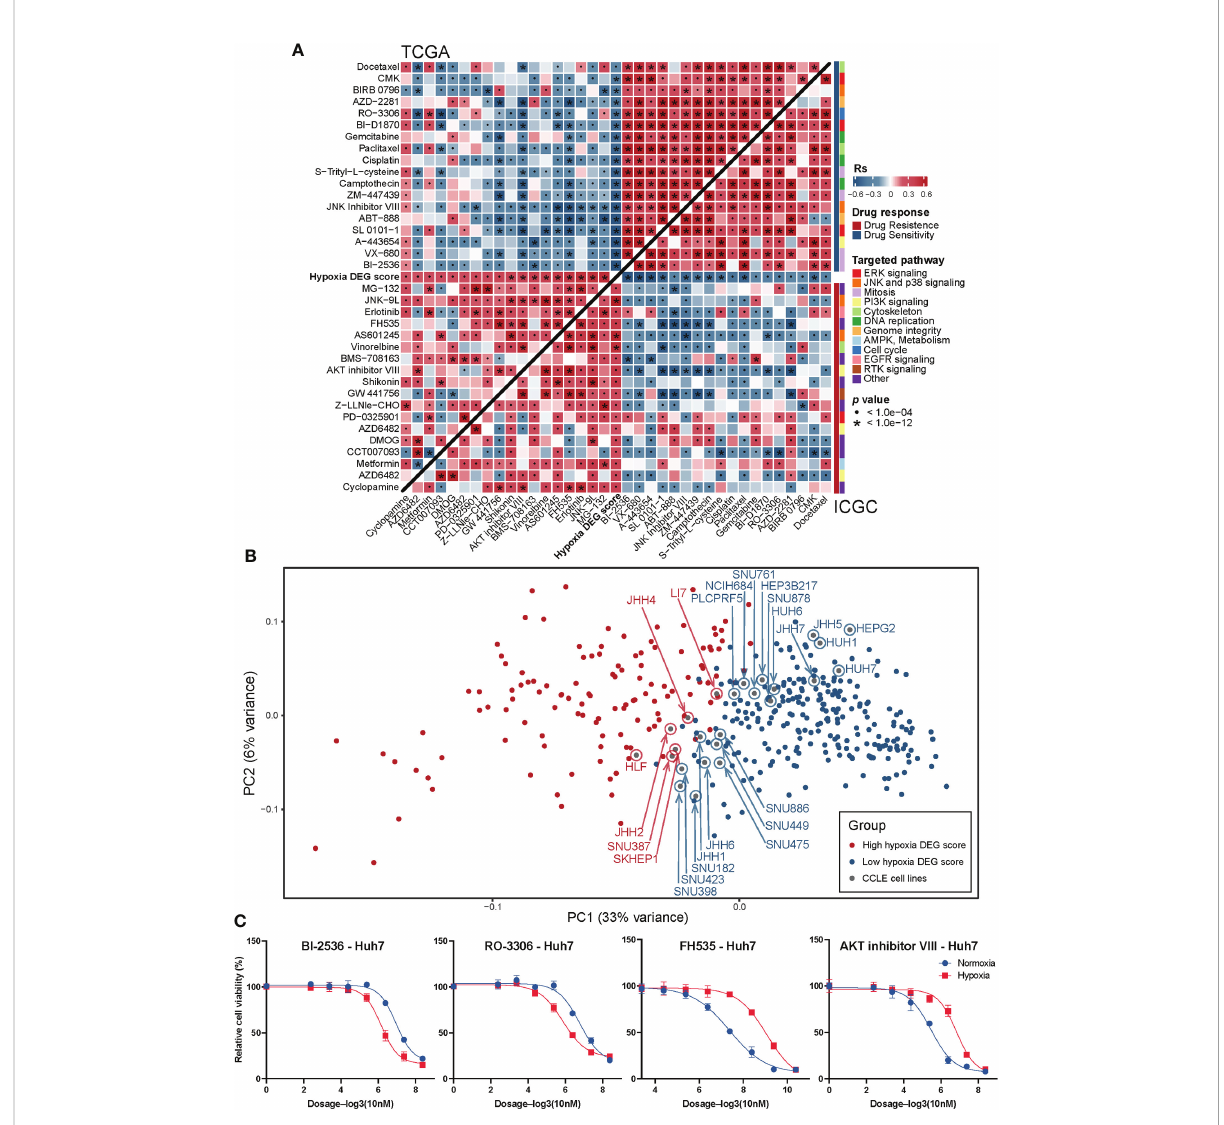
FIGURE 8 Relationship between the Hypoxia_DEGs_Score and drug response. (A) Correlation between the Hypoxia_DEGs_Score and drug sensitivity assessed using Spearman correlation analysis in the TCGA-LIHC and ICGCLIRI-JP cohort. The upper left triangle shows the analysis of the TCGA-LIHC cohort; the lower right triangle shows the analysis of the ICGC-LIRI-JP cohort. Red indicates ineffective drugs (tumor is resistant), and blue indicates effective drugs (tumor is sensitive). Rs is the coef fi cient of rank correlation. Each small rectangle on the right represent the targeted pathways corresponding to the drugs. *P < 1.0e-04; (cid:129) P < 1.0e-12 (B) Principal component analysis for the transcriptome pro fi les of 251 hypoxia-related DEGs based on the combination between HCC cell lines and patient samples from the GDSC dataset and the TCGA-LIHC cohort. Red represents HCC samples and cell lines with high Hypoxia_DEGs_Score values; blue Represents low Hypoxia_DEGs_Score. (C) Dose-response curves for the the mean value of cell viability for BI-2536, RO-3306, FH535, and Akt inhibitor-VIII in the HCC cell lines Huh7 (C) and HepG2 (Figure S12C) incubated under hypoxic (red, n = 4) and normoxic (blue, n = 4) conditions. Cell viability was normalized to that of cells mock-treated with dimethyl sulfoxide (vehicle control). The error bars indicate the mean ± SD. The sigmoidal dose-response curves were fi tted to the